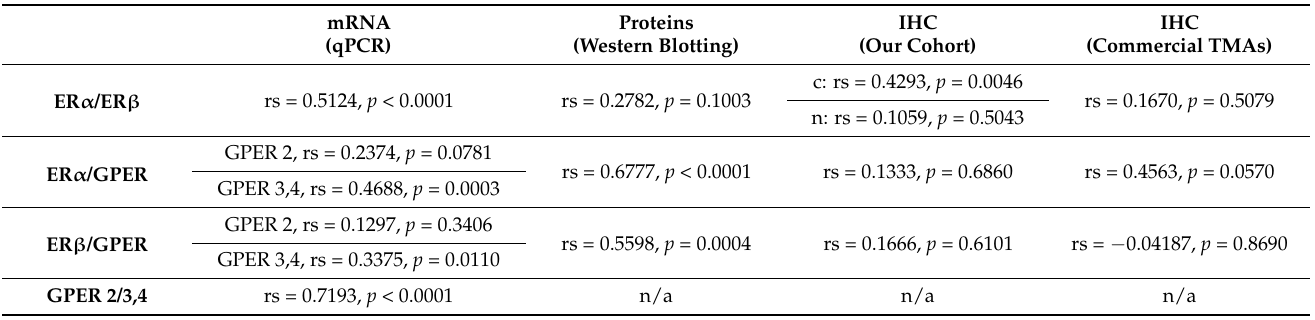
Table 3. Correlation between expression of ER α , ER β , and GPER in EC at the mRNA and protein